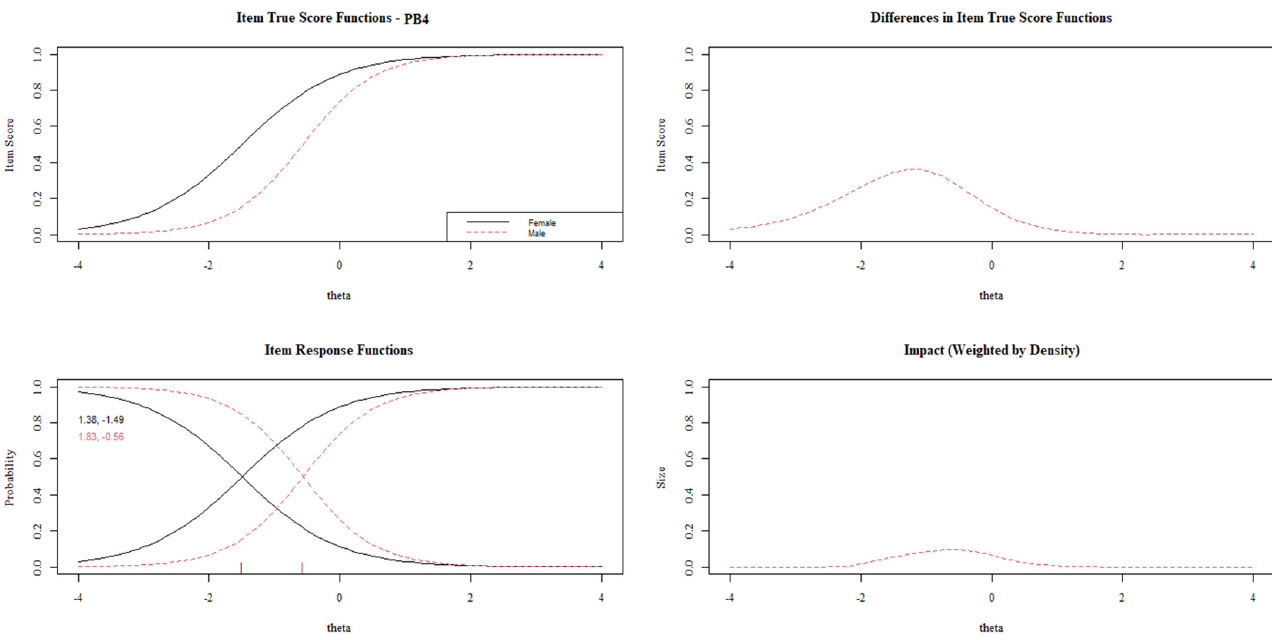
Figure 4. DIF plots for item PB4.